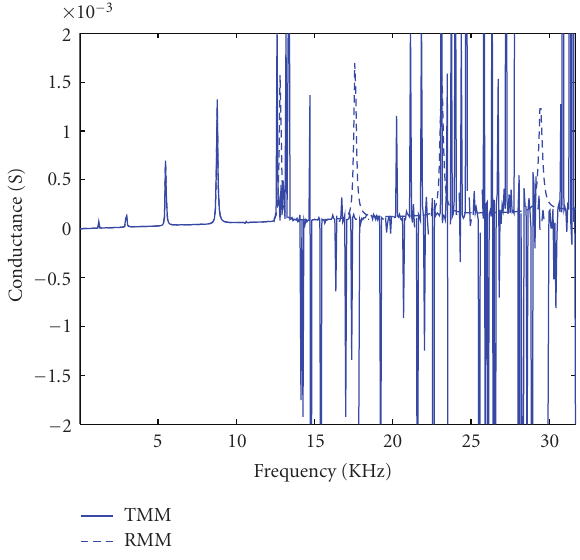
Figure 4: Comparison study with